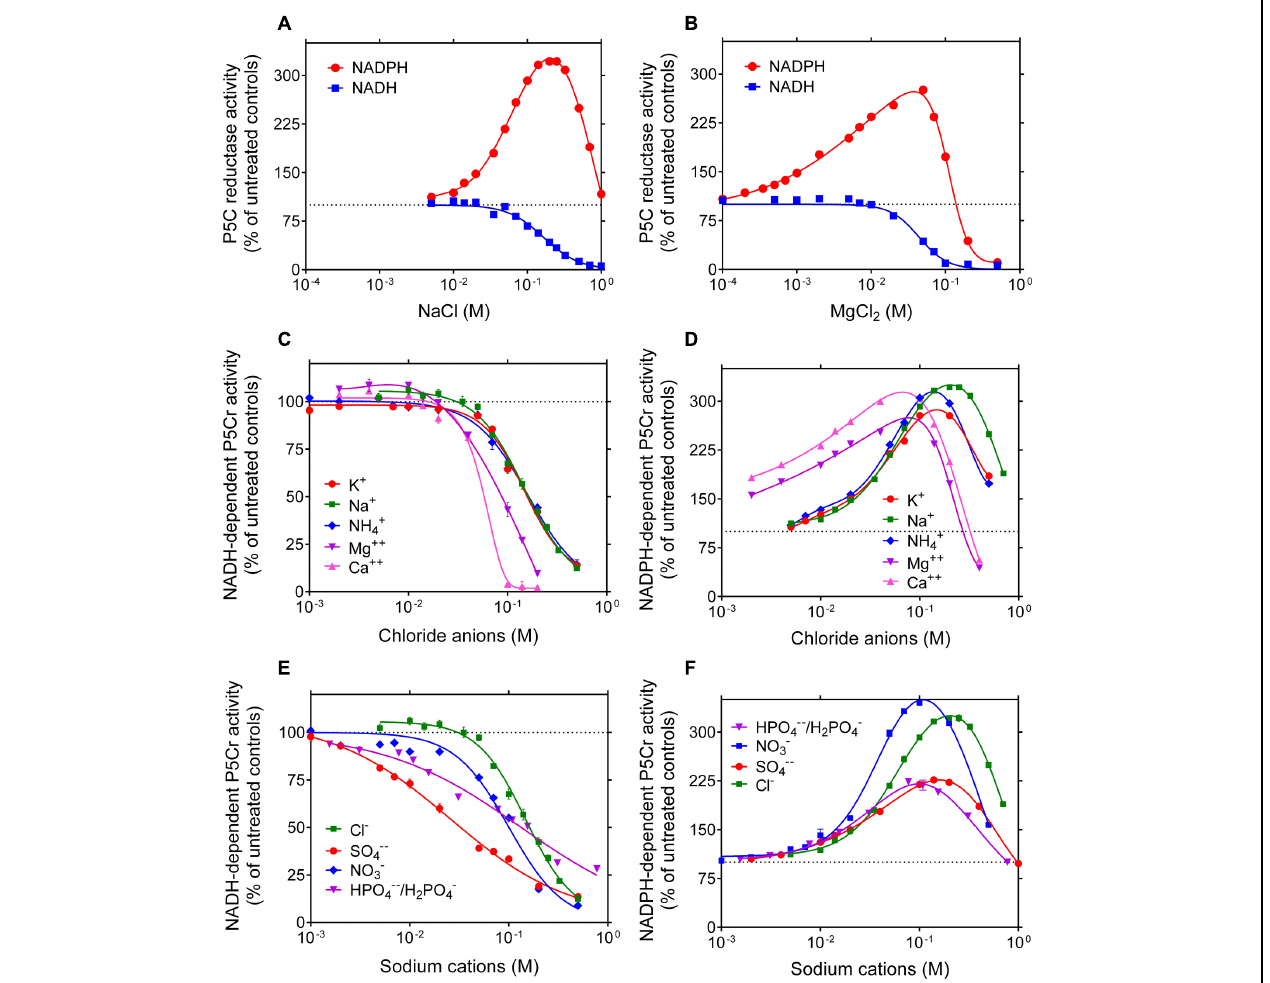
FIGURE 3 | Effect of anions and cations on the activity of rice P5C reductase. The effects of the addition of increasing concentrations of NaCl (A) or MgCl 2 (B) to the reaction mixture were assessed using either 1 mM NADH or 0.5 mM NADPH as the electron donor. To minimize the carry-over of chloride anions from the purified preparation of the co-substrate, L -P5C levels were fixed at 0.2 mM, resulting in less than 10 mM Cl − 1 in standard mixture. Results were expressed as percent of controls assayed in the absence of added salts, and are mean ± SE over three replicates. Non-linear regression analysis allowed the calculation of IC 50 values for the NADH-dependent reaction, which were 165 ± 13 mM and 43.8 ± 3.9 mM for NaCl and MgCl 2 , respectively. To